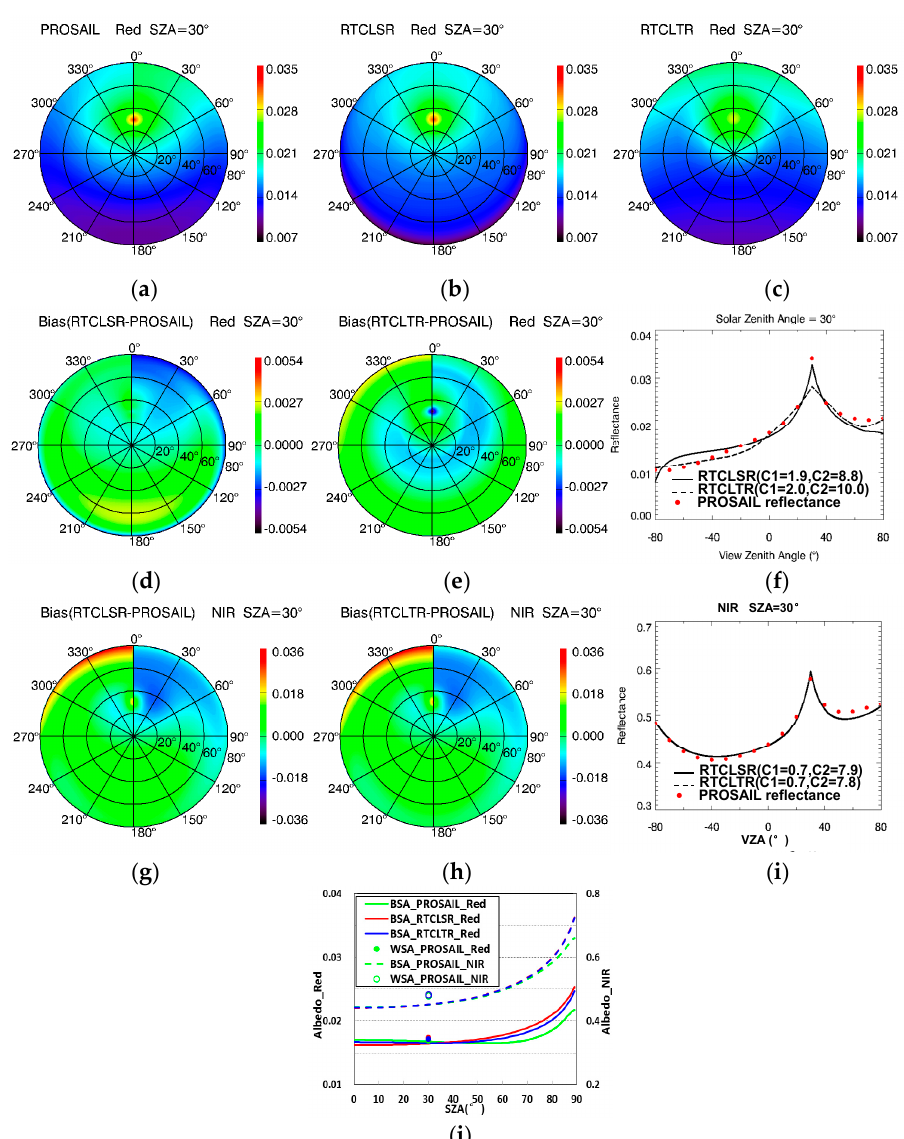
Figure 2. BRDF and albedo comparison of RTCLSR/RTCLTR inversions and PROSAIL simulations for a typical canopy. ( a – c ) the reflectance obtained by the PROSAIL simulations and RTCLSR and RTCLTR inversions for the entire viewing hemisphere in the red band; ( d , e ) the deviations in the red band; ( f ) BRDF of the RTCLSR/RTCLTR models along the principal plane in the red band, where a positive value of VZA on the horizontal axis indicates an observation on the same side as the solar or backward direction; ( g – i ) the same as ( d – f ) but for the NIR band; and ( j ) albedo comparison, where the BSA is related to the SZA from 0 to 89°. Dotted lines refer to the same result as solid lines but for the NIR band, and solid and hollow points refer to the corresponding WSA in the red and NIR bands, respectively.